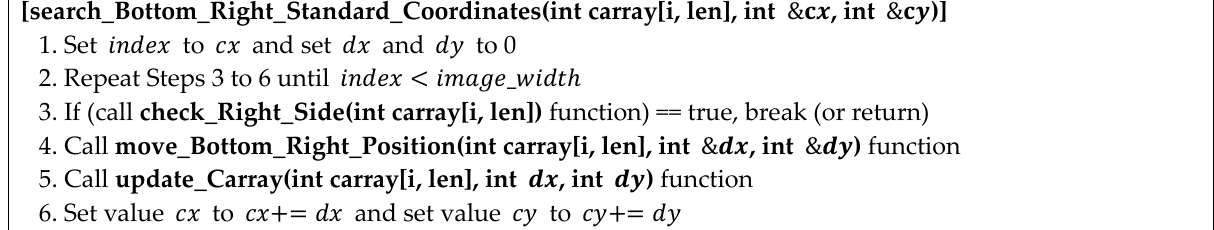
Figure 11. Starting point search process. The pseudocode for searching for the lower-right reference point using the circular coordinate array is shown in Figure 12. The circle center coordinate ( cx , cy ) and the coordinate array carray [i, len] are the inputs. In Figure 12, the check_Right_Side function (Line 3) determines whether the center coordinate of the location is the reference point. If it is the reference point, the search for the reference point is terminated by returning the center coordinate ( cx , cy ) . If not, the gap between the next position moves and the current position is calculated by the move_Bottom_Right_Position function (Line 4) to continue searching for the reference point. Moreover, the gap value is reflected in the circular coordinate array through the update_Carray function (Line 5) and the center coordinate ( cx , cy ) through Line 6.